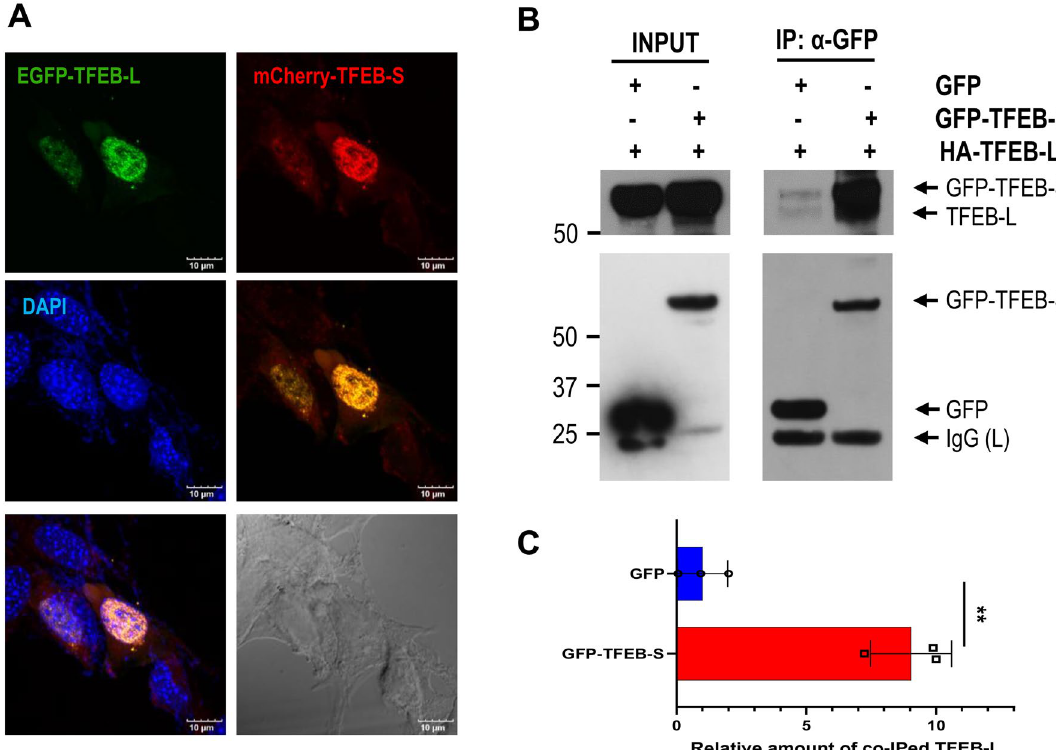
Figure 6. Activated small TFEB associates with full-length TFEB in the nucleus. ( A ) T4 cells were transiently co-transfected with EGFP-tagged TFEB (EGFP-TFEB-L) and mCherry-tagged small TFEB (mCherry- TFEB-S) and treated on the next day with 500 nM Torin1 for 1 h. Images were obtained using a confocal microscope (Olympus Corp., FV3000-ORS). ( B ) HEK293 cells were transiently co-transfected with the HA-TFEB expression plasmid and either the plasmid expressing EGFP-tagged small TFEB (GFP-TFEB-S) or the mock plasmid expressing only the GFP protein. The cells were treated with 500 nM Torin1 for 10 min. The cell lysates were used for small TFEB immunoprecipitation using an anti-GFP antibody. The protein level of small TFEB co-immunoprecipitated with TFEB-L was examined by immunoblotting using an anti-TFEB antibody. Full blots are provided in Supplementary Fig. S6. ( C ) Bar graph represents the relative amount of TFEB-L co-immunoprecipitated with small TFEB. The data are shown as the mean ± S.E. of three independent experiments and were analyzed using Student’s t test. (** p <